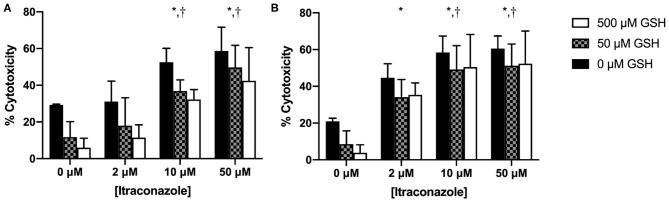
Percent cytotoxicity of hepatocytes treated with GSH and ITZ (A) 4 h and (B) 24 h after ITZ exposure. *, significantly different from 0 μM ITZ; †, significantly different from 2 μM ITZ.